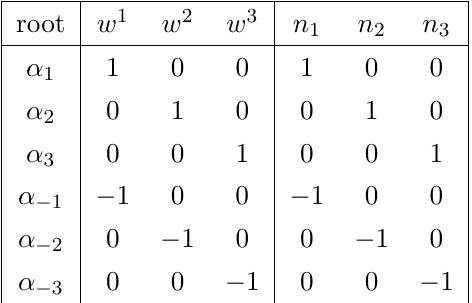
Table 11 . Momentum and winding numbers of the massless vectors at the SU(2) 3 enhancement point of T 3 .